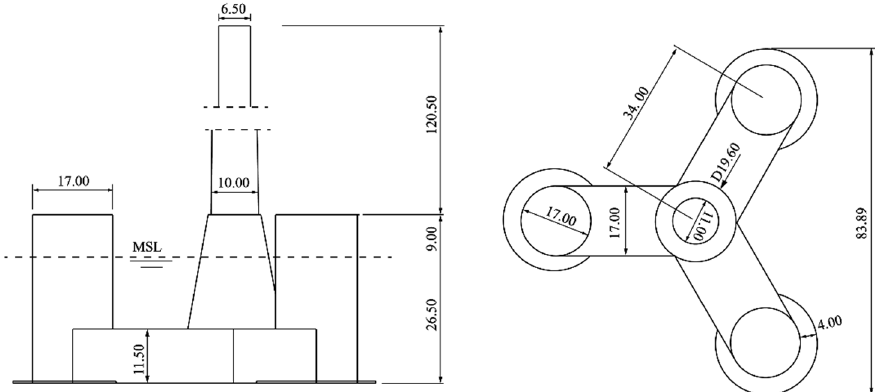
Figure 2. Geometry of the ActiveFloat platform.